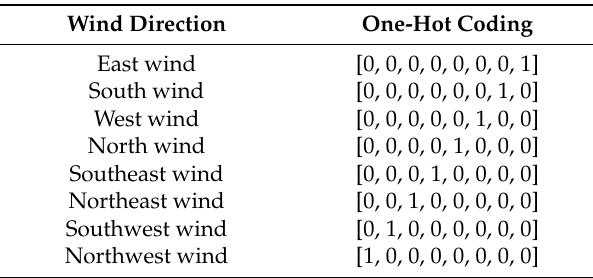
Table 1. Wind direction one-hot coding